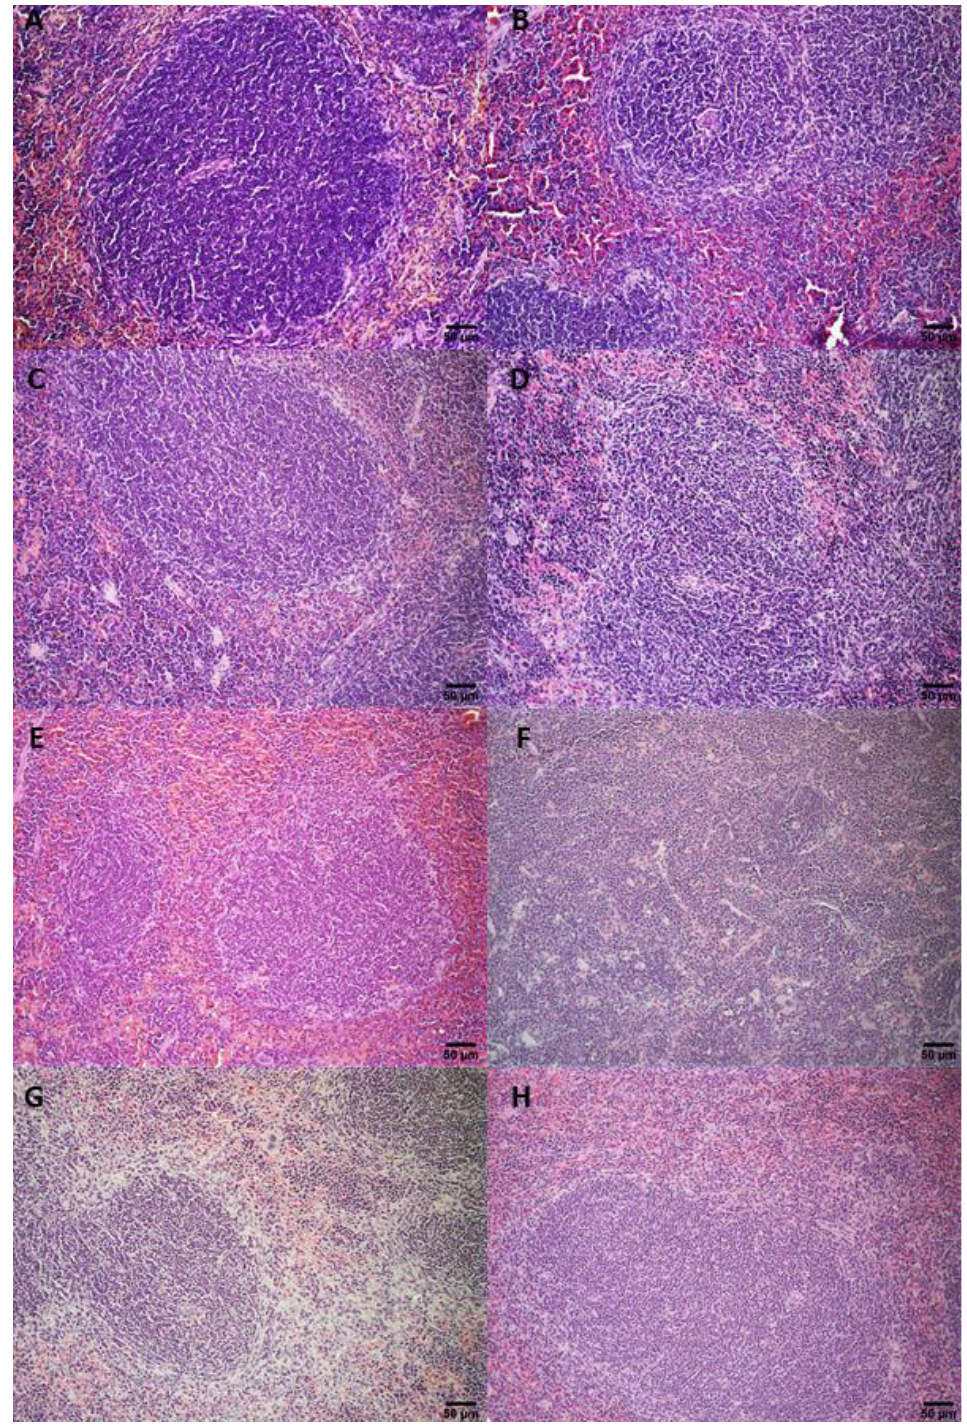
Figure A4. Histological sections of female Balb/c mice spleen. ( A ) Control group (HBS), ( B ) ExoSpHL, and ( C ) SpHL-DOX at a dose of 15 mg/kg, ( D ) SpHL-DOX at a dose of 17.5 mg/kg, ( E ) ExoSpHL-DOX at a dose of 15 mg/kg, ( F ) ExoSpHL-DOX at a dose of 17.5 mg/kg, ( G ) DOX at a dose of 10 mg/kg, ( H ) DOX at a dose of 12.5 mg/kg.